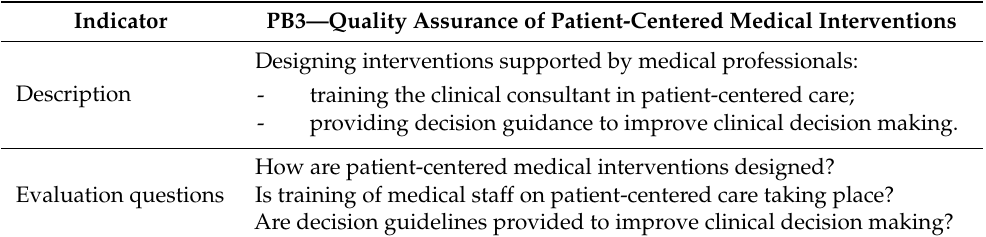
Table A3. The indicator PB3–Quality assurance of patient-centered medical